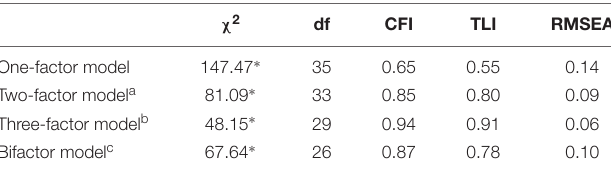
TABLE 4 | Fit indices for the tested models ( n =